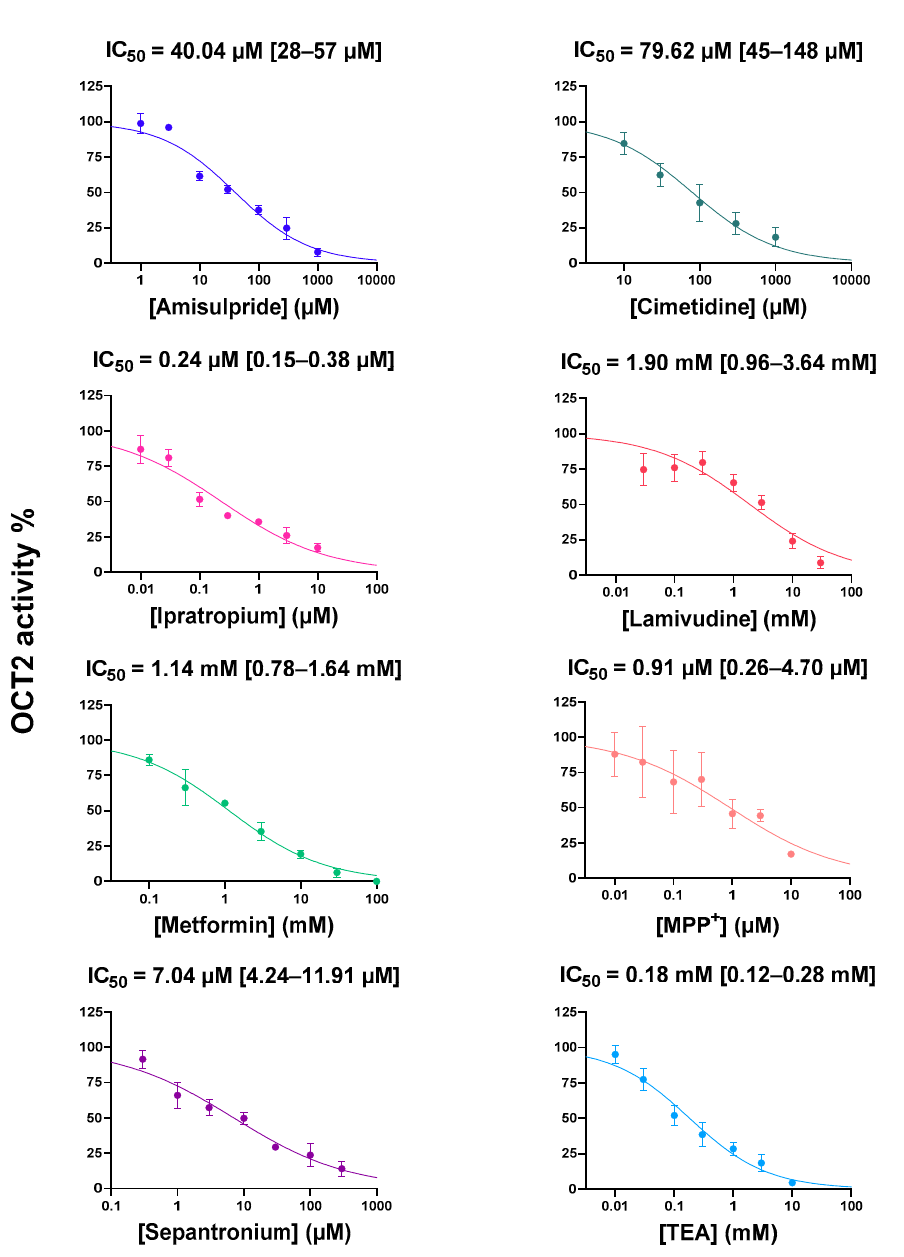
Figure 1. Cis -inhibition of OCT2 activity by exogenous OCT2 substrates. HEK-OCT2 cells were incubated with 10 µ M DiASP, used here as a tracer substrate for OCT2, for 5 min at 37 ◦ C, in the absence or presence of various concentrations of exogenous OCT2 substrates. Intracellular accumulation of DiASP was next determined by spectrofluorimetry and normalized to protein content. Data are expressed as % of OCT2 activity found in untreated control cells, arbitrarily set at 100%; they are the means ± SEM of at least three independent experiments performed in quadruplicate. IC 50 values and 95% confidence intervals are indicated on the top of graphs.